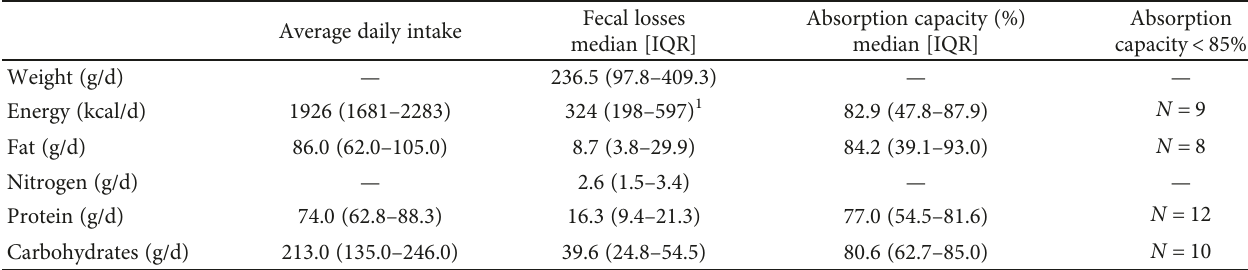
Table 3: Fecal energy losses, intestinal absorption capacity, and exocrine pancreatic